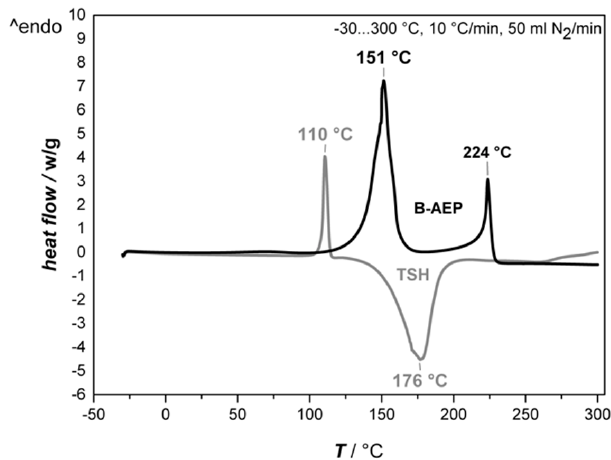
Figure 2. Di ff erential scanning calorimetry (DSC) first heating curves of B-AEP and Figure 2. Differential scanning calorimetry (DSC) first heating curves of B-AEP and TSH.